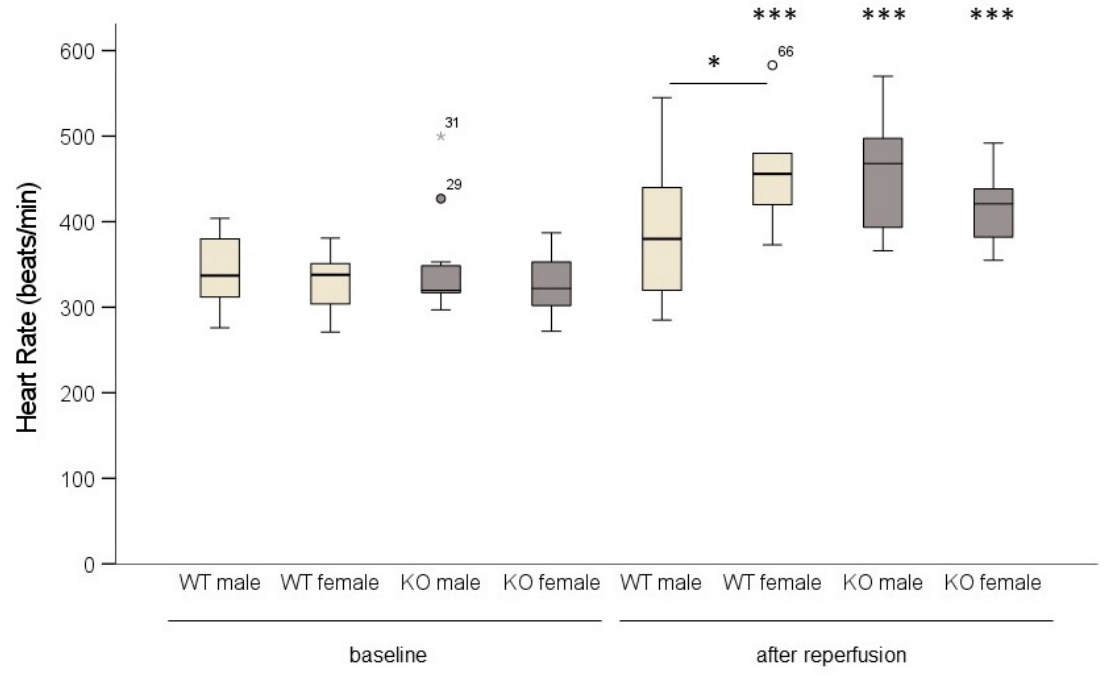
Figure 3. In male wild-type (WT) mice, heart rate did not increase following ischemia/reperfusion. WT and cardiomyocyte-specific MAO-B knockout (KO) hearts were exposed to 45 min ischemia and 120 min reperfusion. Heart rate was measured baseline and after reperfusion. (WT male n = 14; WT female n = 9; KO male n = 11; KO female n = 11). Data are represented as box plots expressing median, 25% and 75 % quartiles, upper and lower whisker and outliers ( , ). * p < 0.05, *** p < 0.001 baseline (cid:35) vs. after reperfusion, Student’s t -test. Two-way ANOVA: p < 0.001, baseline vs. after reperfusion p < 0.001, genotype * sex p =